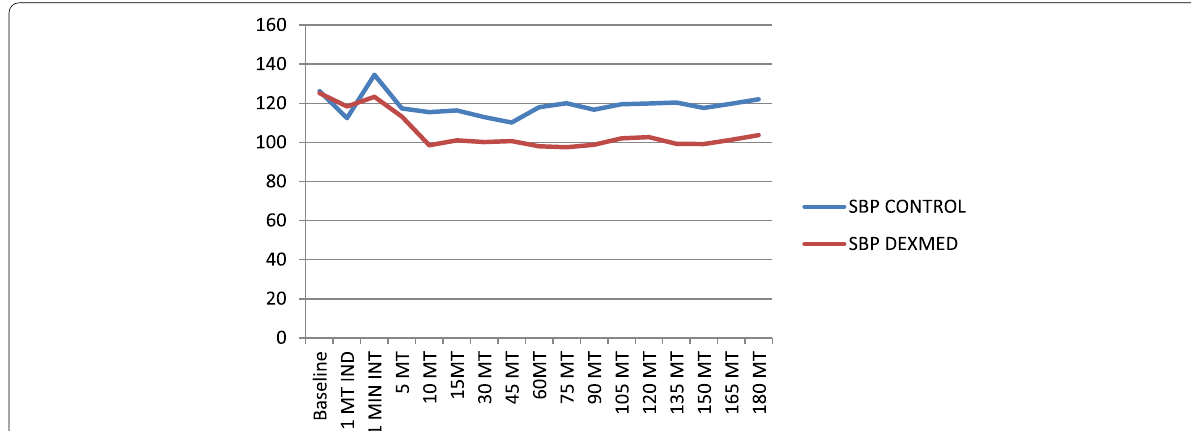
Fig. 5 Systolic blood pressure response with the control and dexmeditomidine groups